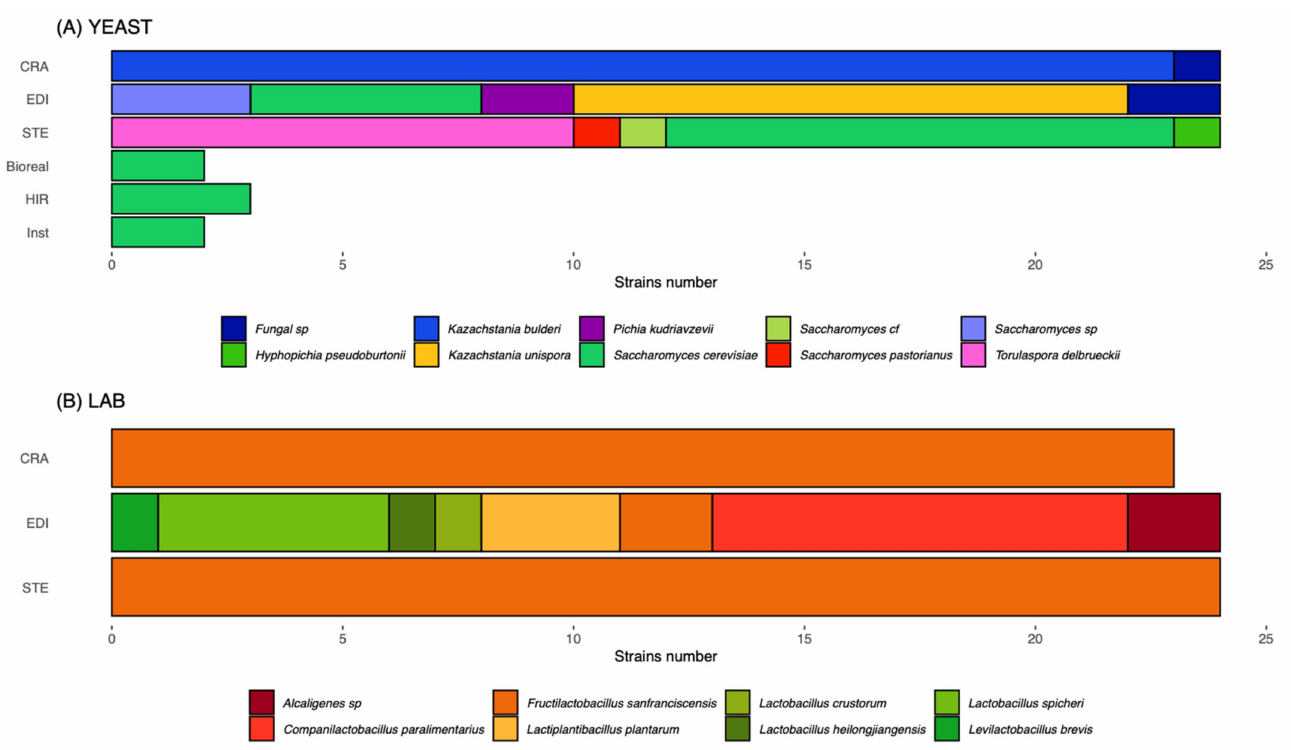
Figure 2. Diversity of yeast and LAB species in the three sourdoughs (“CRA” from Collectif Cravirolla, “EDI” from Edith Brissiaud, “STE” from St é phane Marrou) and in the three commercial yeasts (Hirondelle fresh yeast—Lesaffre, “HIR”, Bioreal organic fresh yeast—Europ-Labo, “Bioreal” and Saf-instant instant yeast—Lesaffre, “Inst”). Twenty-four yeast strains were characterized for each sourdough and two to three strains for each yeast starter. Twenty-three or twenty-four LAB strains were characterized per sourdough. Each colour refers to a different species. Each line refers to a different leavening agent. The abscise indicates the number of strains of each